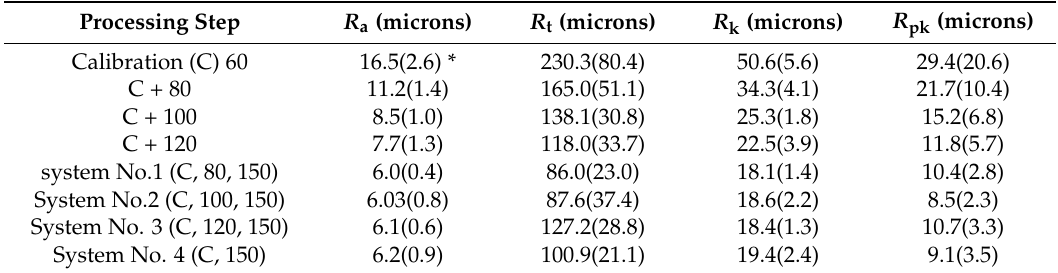
Table 3. Average values of surface roughness per each intermediate sanding sequence and final sanding system.